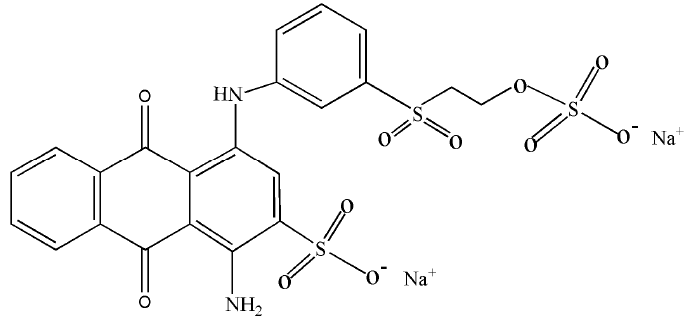
Figure 1. Molecular structure of reactive blue 19.